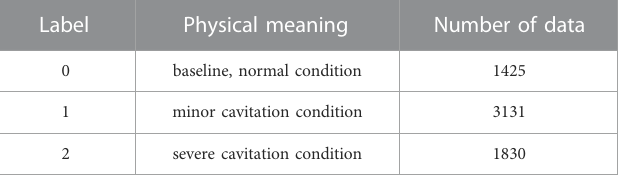
TABLE 1 Physical meaning and number of sub-datasets.